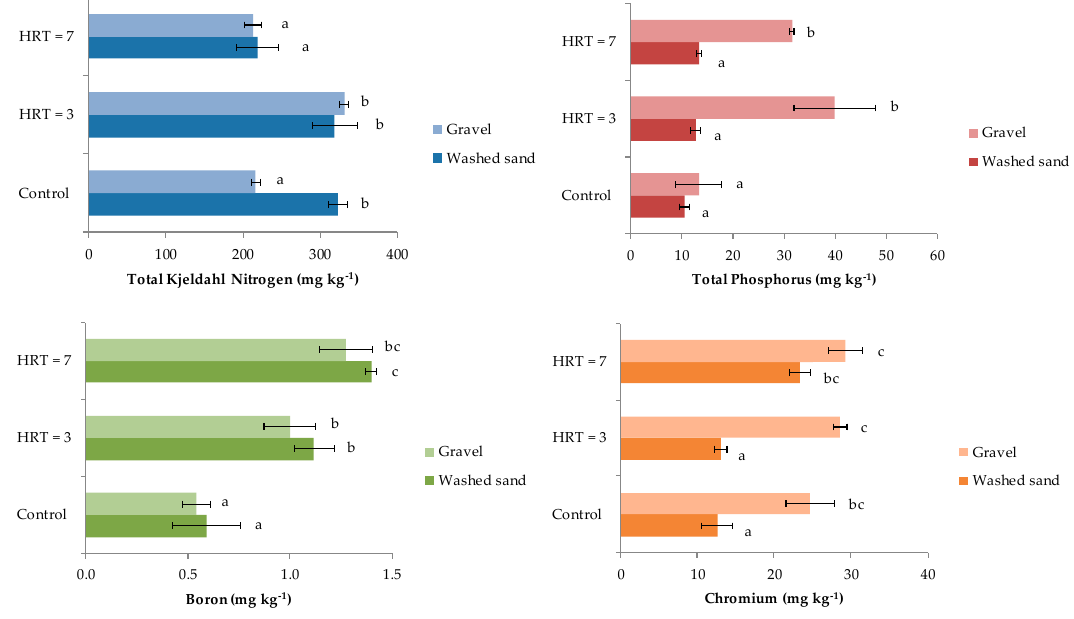
Figure 3. TKN, TP, B and Cr adsorption by the substrate.